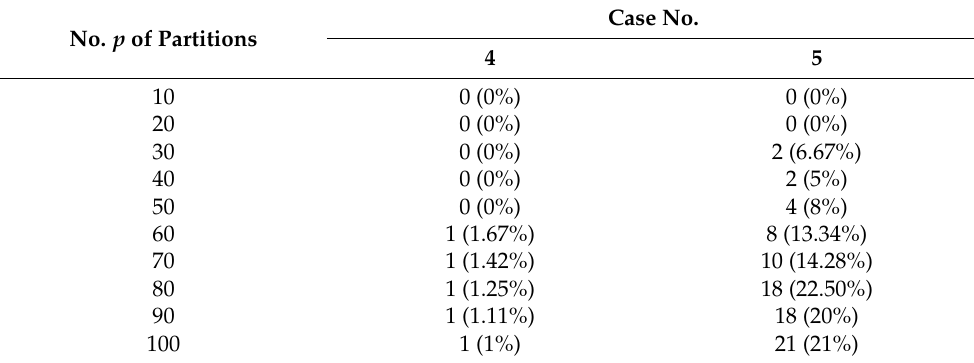
Table 5. ASCE problem: effect of the number p of partitions of the matrices X and Z on the occurrence and percentage of false damage detections for Cases 4 and